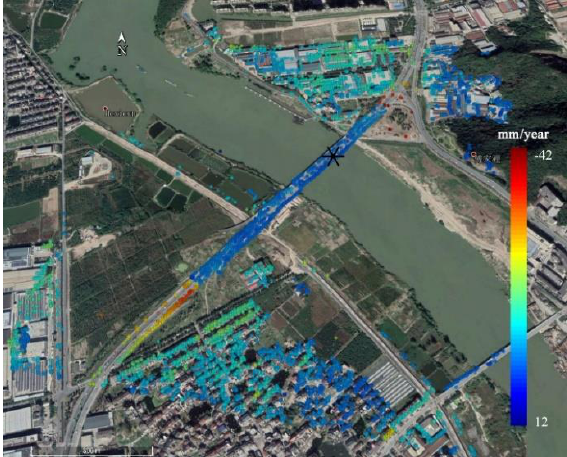
Figure 2. In this paper, the point selection method is used to obtain the deformation velocity A comparative experiment was carried out to select points in this area based on conventional amplitude information. The amplitude deviation threshold and average amplitude threshold are set to 0.33 and 1.2 respectively to ensure the quality of point target selection and reduce the influence of pseudo points on the final deformation velocity. 6742 permanent scatterers